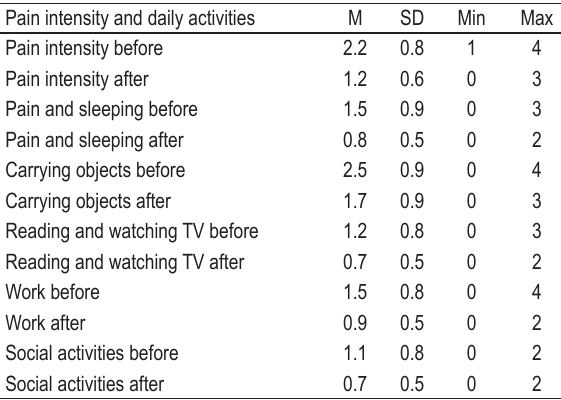
TABLE 11. Descriptive values of measured variables of pain